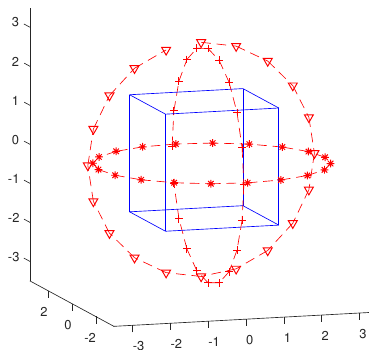
Figure 3. The physical setup for the numerical